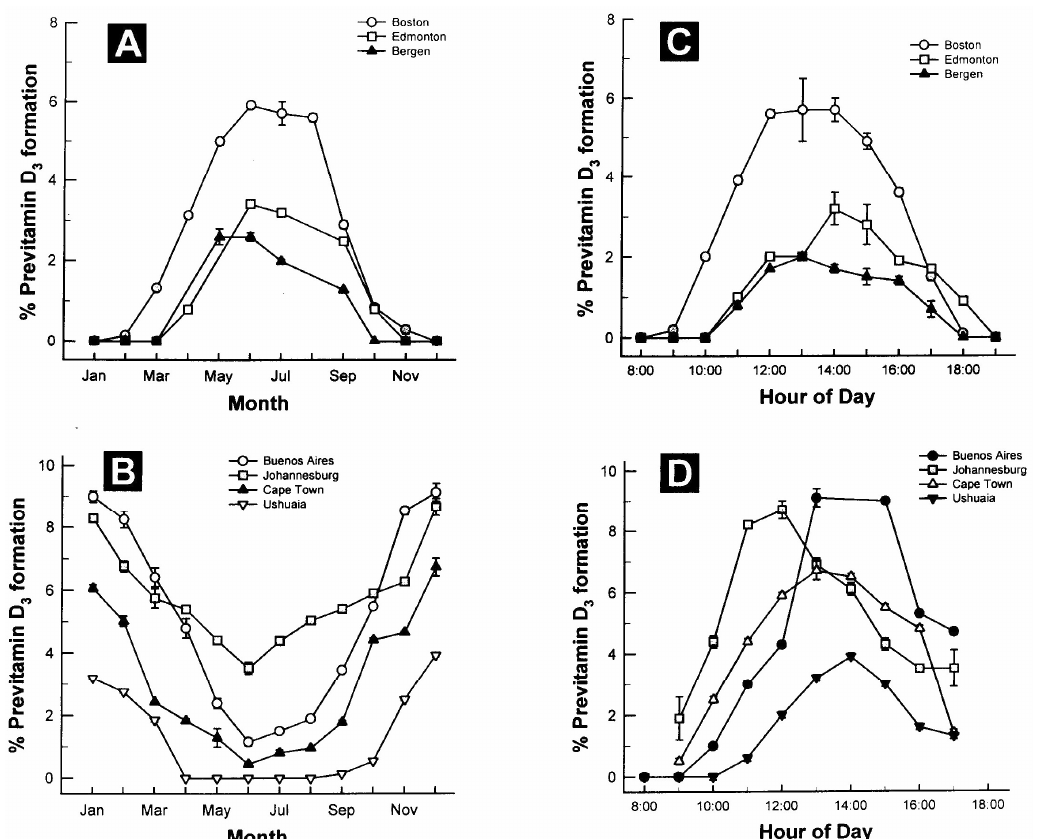
Figure 2. Influence of season, time of day, and latitude on the synthesis of previtamin D in Northern ( A and C ) and Southern hemispheres ( B and D ). The hour indicated in C and D is the end of the 1-h exposure time. Note: This figure is reproduced with permission from [13], Copyright © 2010 Humana